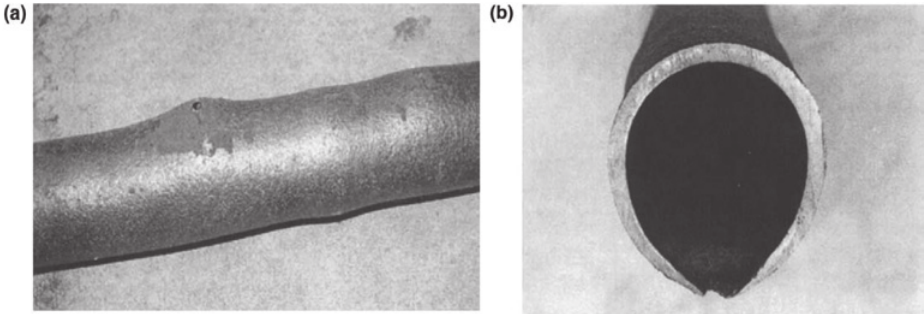
Fig. 6: Tube bulge of as received sample: (a) general view and (b) cross-section [21].